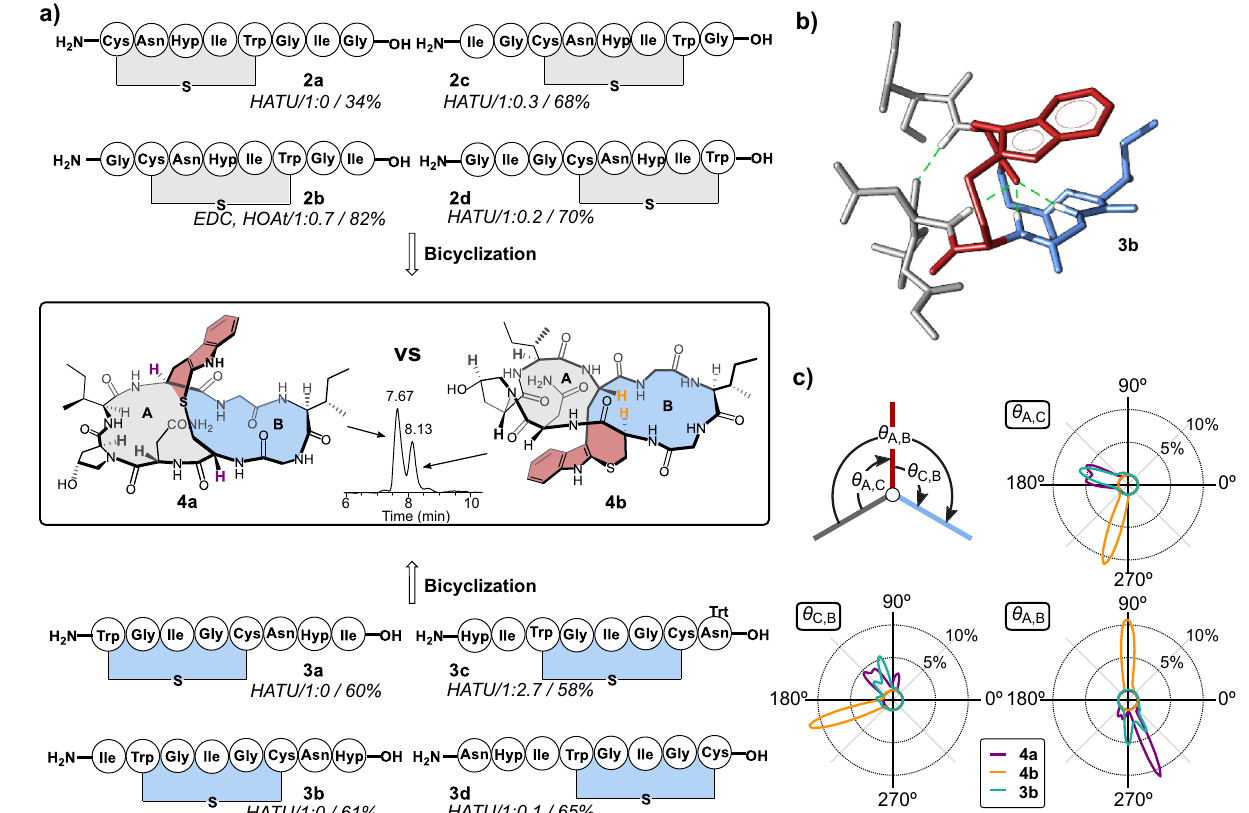
Fig. 2 | Peptide precursor choice impacts isomer yields. a Bicyclization condi- tions (HATU or EDC/HOAt) and different ring closure sites with preformed A-ring 2a-d (gray) or B-ring 3a-d (blue) lead to different isomer ratios ( 4a : 4b ) and yields ( 4a + 4b ). b MD-simulated structure of precursor 3b with highest probability. Hydrogen bonds are shown as green dashed lines. The structure is colored according to the scheme in Fig. 1e. c Illustration of the model system to assess the relative orientation of the A-ring, B-ring, and tryptathionine bridge in the amanitin